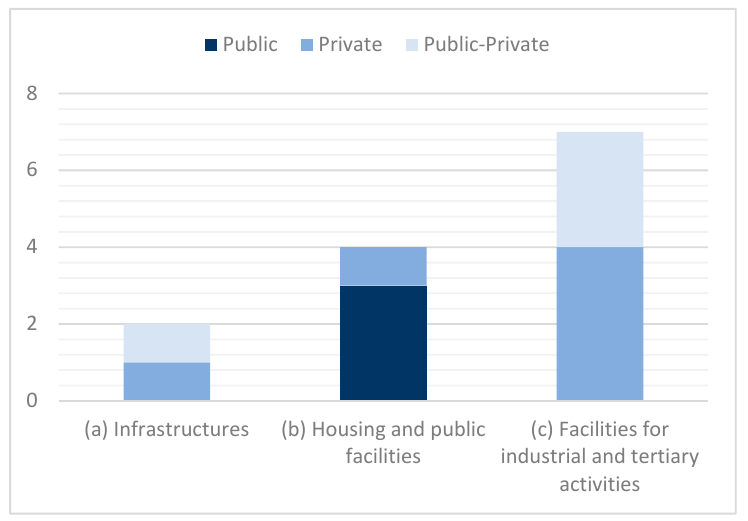
Figure 2. PSIs in Castilla–La Mancha by type and form of promotion. Source: own preparation using available documentation.